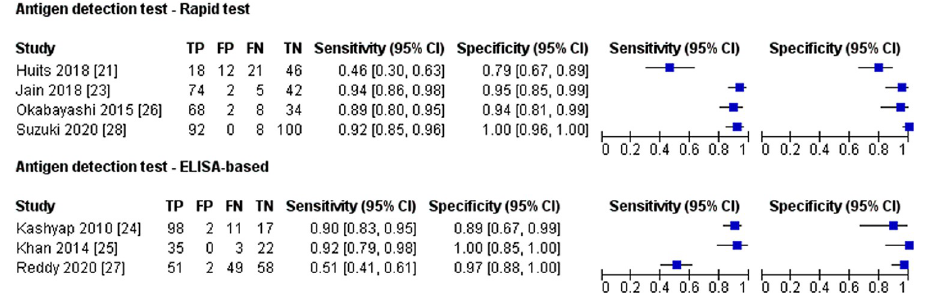
Fig 2. Forest plot for antigen detection test based on test format; CI, confidence interval; TP, true positive; FP, false positive; FN, false negative; TN, true negative.